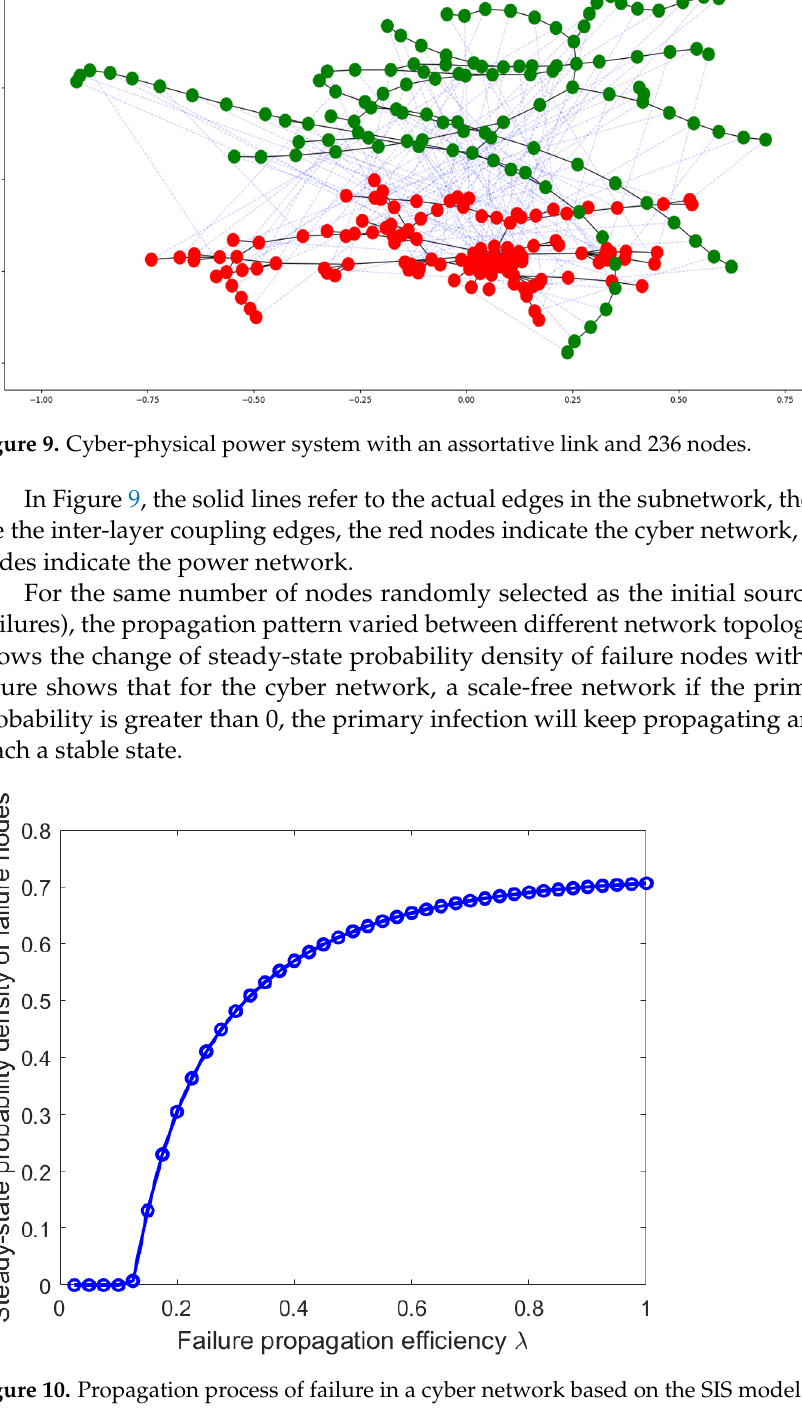
Figure 10. Propagation process of failure in a cyber network based on the SIS model. Figure 11 shows the change of steady-state probability density of failure nodes with λ . As power systems have certain small-world characteristics, failures do not last long without long-range random propagation.